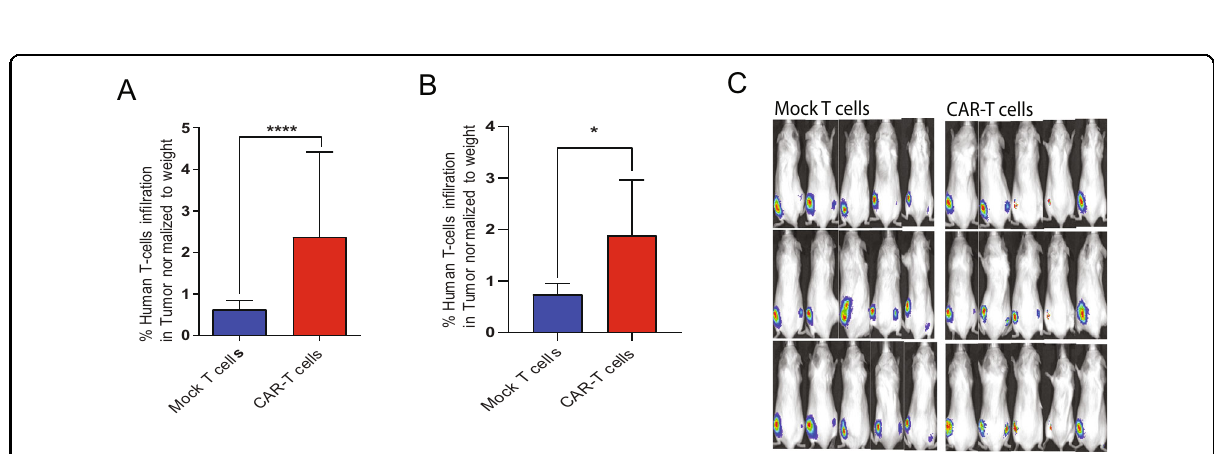
Fig. 6 CD126-targeted CAR-T cells demonstrated potent antitumor activity in murine models of multiple myeloma and prostate cancer. a Tumor-in fi ltrating human T cells were quanti fi ed by anti-human CD3 antibody using fl ow cytometry in RPMI tumors explanted from mice that either received mock T cells ( n = 8) or CAR-T cells ( n = 10). b Tumor-in fi ltrating human T cells was quanti fi ed by anti-human CD3 antibody using fl ow cytometry of DU145-explanted tumors from mice that either received mock T cells ( n = 5) or CAR-T cells ( n = 4). c Representative images from fi ve mice are shown from DU145 xenograft model. Mann – Whitney U non-parametric test. * P < 0.05 and **** P < 0.0001.